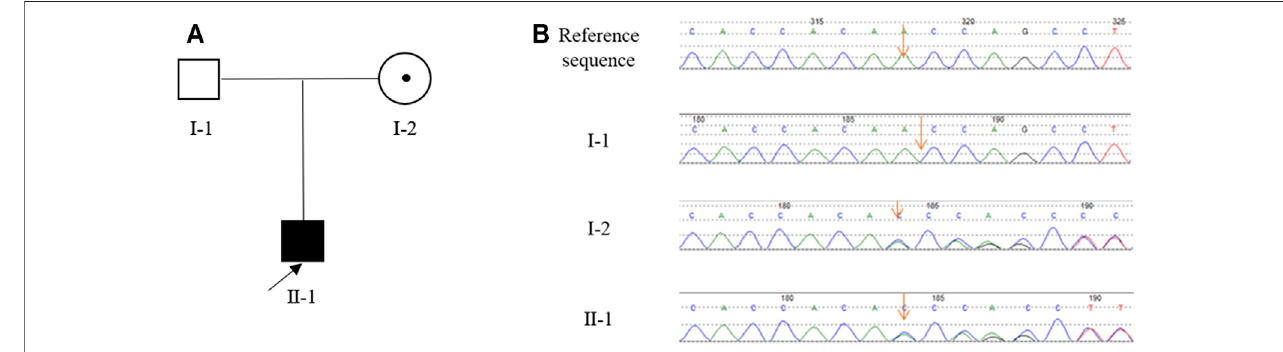
FIGURE1| ThepedigreeoftheChinesefamilywithHypoPPandtheresultofSangersequencing. (A) ,ThepedigreeoftheChinesefamily.Theblackboxrepresents theHypoPPindividual;theblackpointrepresentsthemyasthenicphenotype. (B) ,AnalysisoftheDNAsequence.Electropherogramsshowthesequenceencompassing the heterozygous frameshift mutation c.1364delA (p.Asn455fs) in CACNA1S in the proband (II-1) and his mother